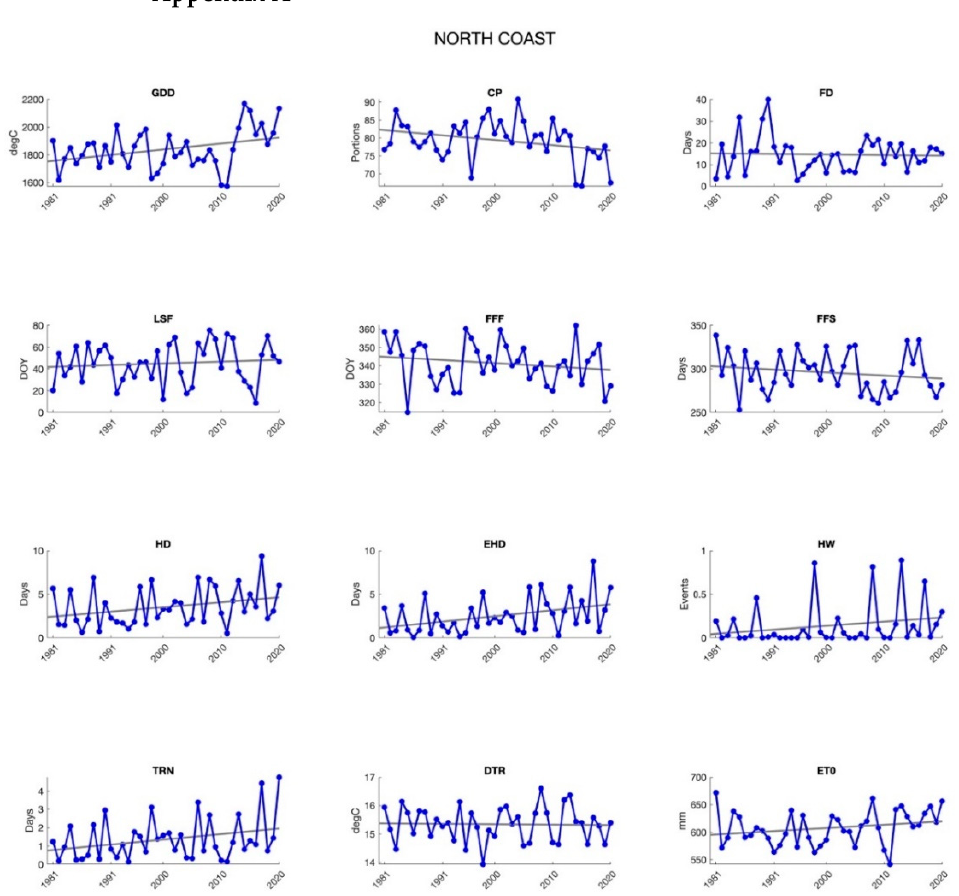
Figure A1. Annual agroclimate metrics averaged over the North Coast region with linear trendline. Metrics are shown as: row 1: growing degree days (GDD), chill portions (CP), frost days (FD); row 2: last spring freeze (LSF), first fall freeze (FFF), frost-free season (FFS); row 3: heat days (HD), extreme heat days (EHD), heatwaves (HW); row 4: tropical nights (TRN), diurnal temperature range (DTR), summer reference evapotranspiration (ETo). GDD and EHD have statistically significant trends over the 40-year period.